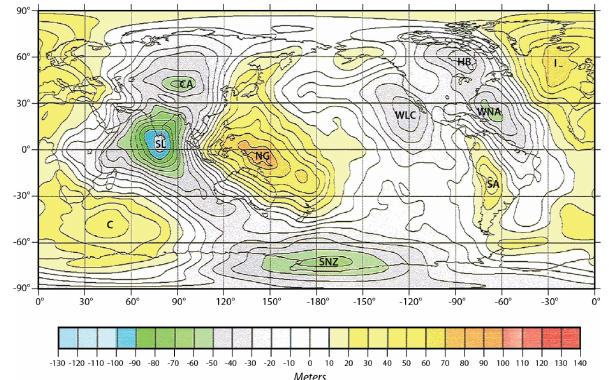
Figure 2. Earth’s geoid anomaly map for spherical harmonic de- gree ranges 2–250. Computed Goddard Earth Model GEM-t2 coef- ficients (Marsh et al., 1990) are referenced to ellipsoid with recip- rocal flattening of 298.257 (actual Earth flattening).